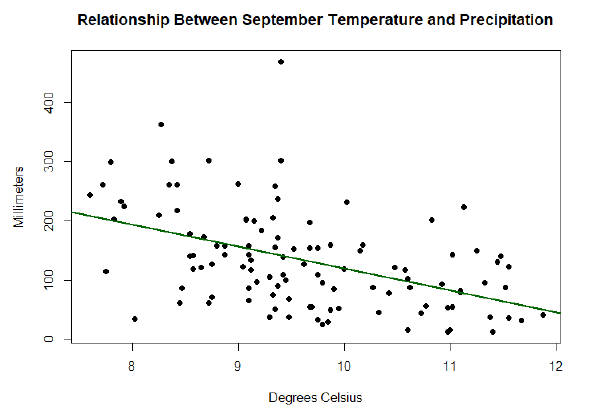
Figure A5. Shows the correlations between different climate variables. Figure A5. shows the correlations between different climate variables. Table A1. Shows the values for the correlations shown in Figure A5. Table A1. shows the values for the correlations shown in Figure A5. Climate Variable Correlations